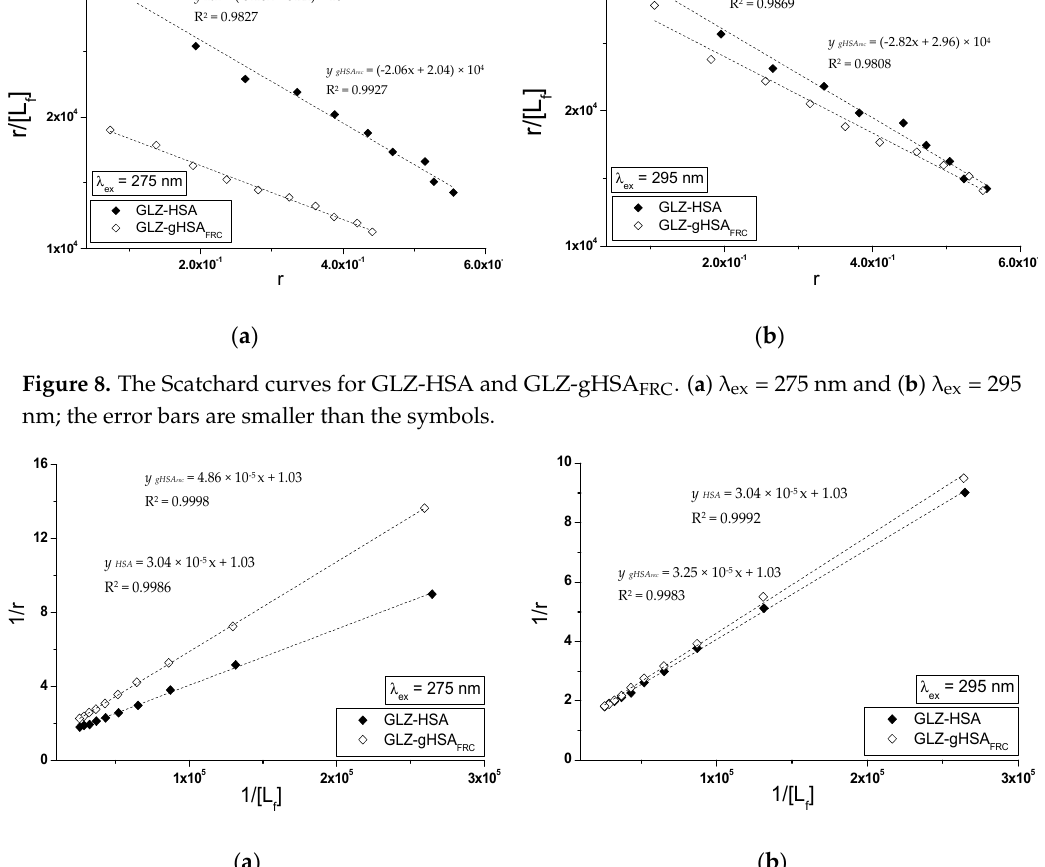
( b ) Figure 10. The Hill curves for GLZ-HSA and GLZ-gHSA FRC . ( a ) λ ex = 275 nm and ( b ) λ ex = 295 nm; the error bars are smaller than the symbols. The changes in high affinity binding of GLZ to HSA and gHSA FRC evaluated on the basis of association constants 𝐾 (cid:2911) (mol -1 ∙ L), the number of GLZ moles bound with 1 mole of albumin (HSA and gHSA FRC ) the number of binding ( 𝑛 ) and also Hill’s coefficient ( 𝑛 (cid:2892) ) obtained for GLZ-HSA and GLZ- gHSA FRC systems at λ ex = 275 nm and λ ex = 295 nm have been calculated and summarized in Table 3. Table 3. Association constants 𝐾 (cid:2911) (mol − 1 ∙ L), mean number of GLZ moles bound with one mole of HSA and gHSA FRC ( 𝑛 ), and the Hill’s coefficient ( 𝑛 (cid:2892) ) in GLZ-HSA and GLZ-gHSA FRC systems; λ ex = 275 nm and λ ex = 295 nm.